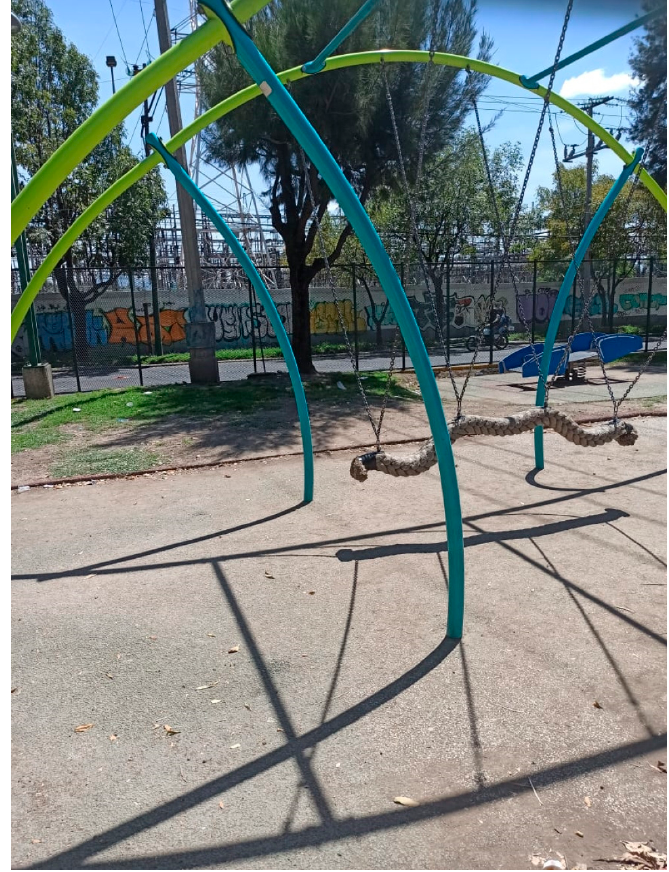
Figure 7. ‘Park’ near Participant 5’s home (Álvaro Obregón).